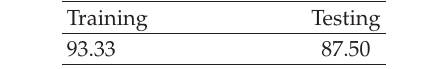
Table 3: Prediction accuracy of the second model. Training Testing 93.33